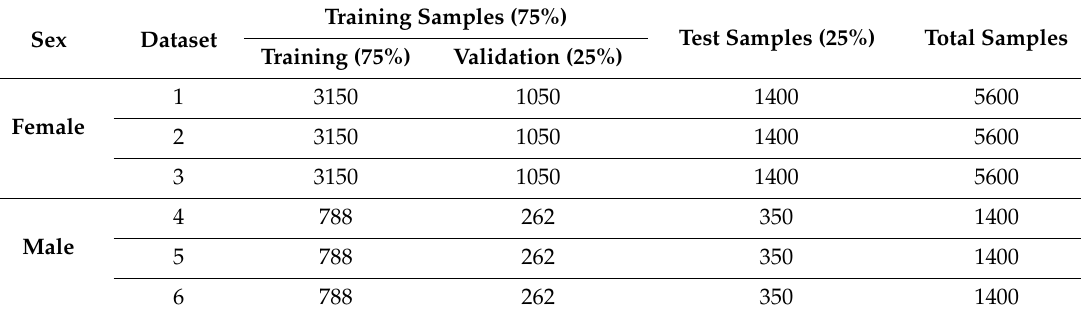
Table 2. Details of datasets used for training and testing the ResNet.